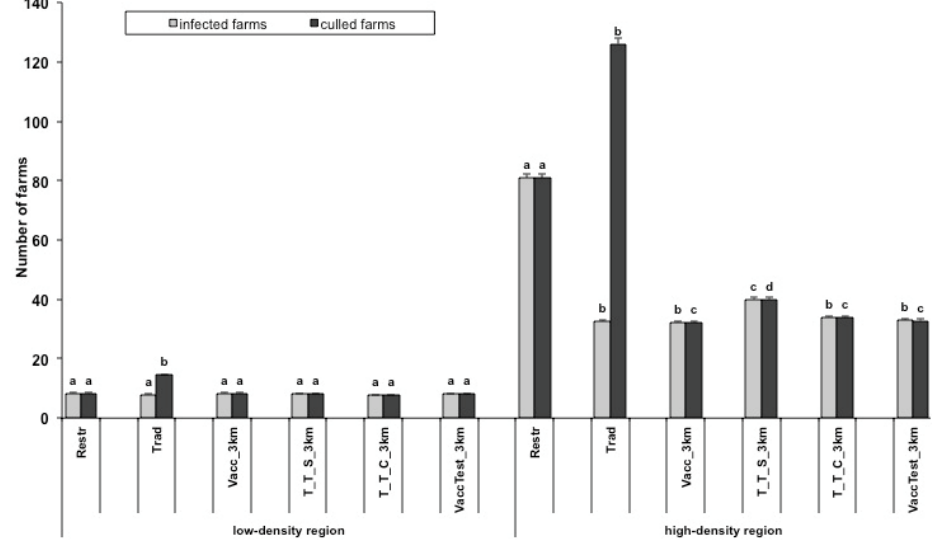
LSM number of infected farms for both regions for the six control strategies using a 3 km or 10 km application radius Infected farms Low-density region High-density-region 3 km 10 km 3 km 10 km Restr 8.4 80.9 7.9 32.6 Vacc 8.4a 7.6a 32.4a 29.4a T_T_S 8.3a 7.6a 39.9a 32.7b T_T_C 7.7a 7.6a 34.3a 31.7a VaccTest 8.2a 7.4a 33.0a 29.0b Different letters indicate significant differences within control strategy and region,